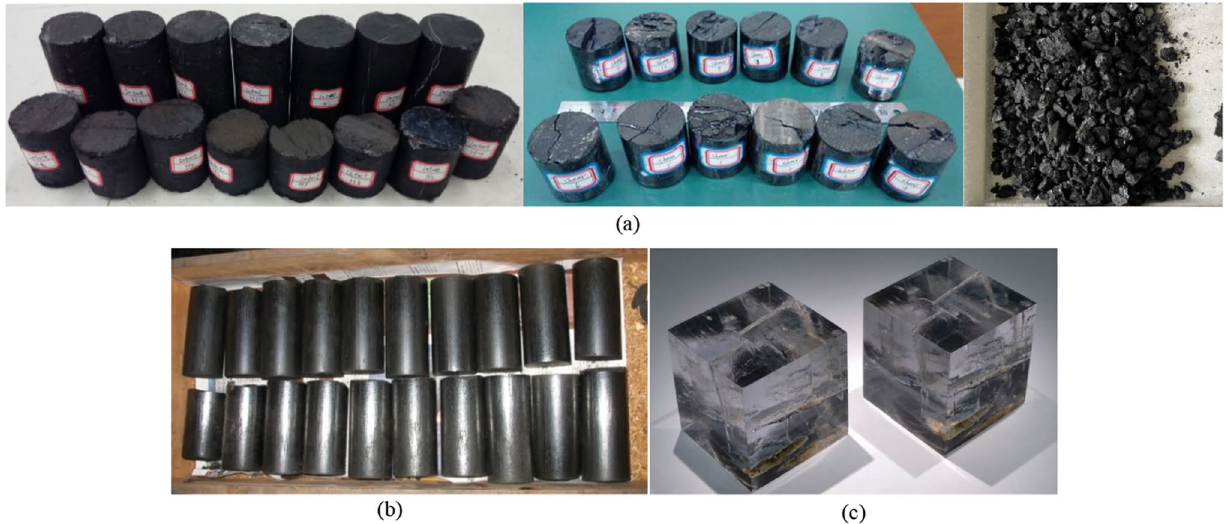
Fig. 2 Macroscopic comparison of three coal types: a Common coal samples (Zhang et al. 2018a, b; Kan et al. 2021), b Briquettes, c New mate- rial coal